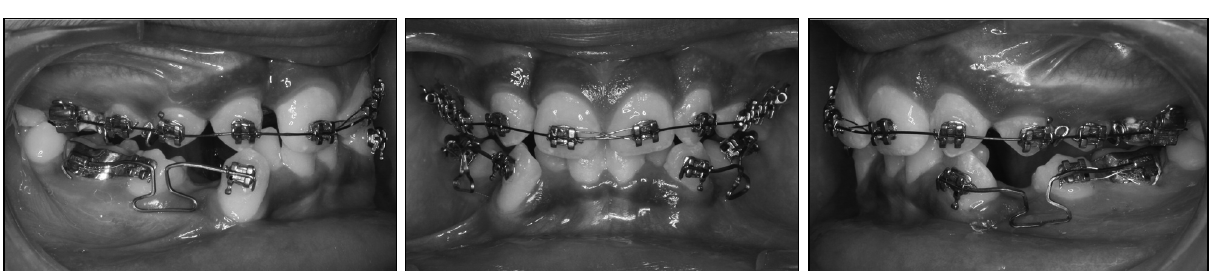
Figure 3. Post-functional treatment.